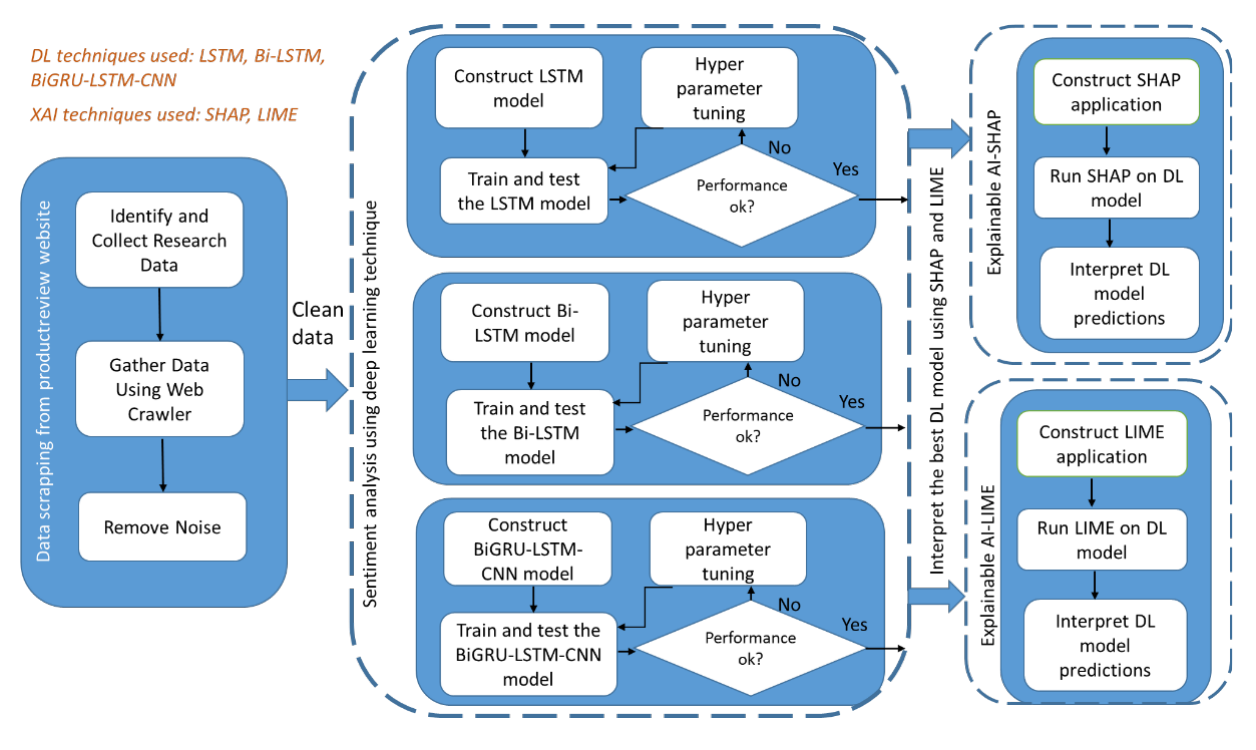
Figure 1. Methodology flow chart adopted in this work.